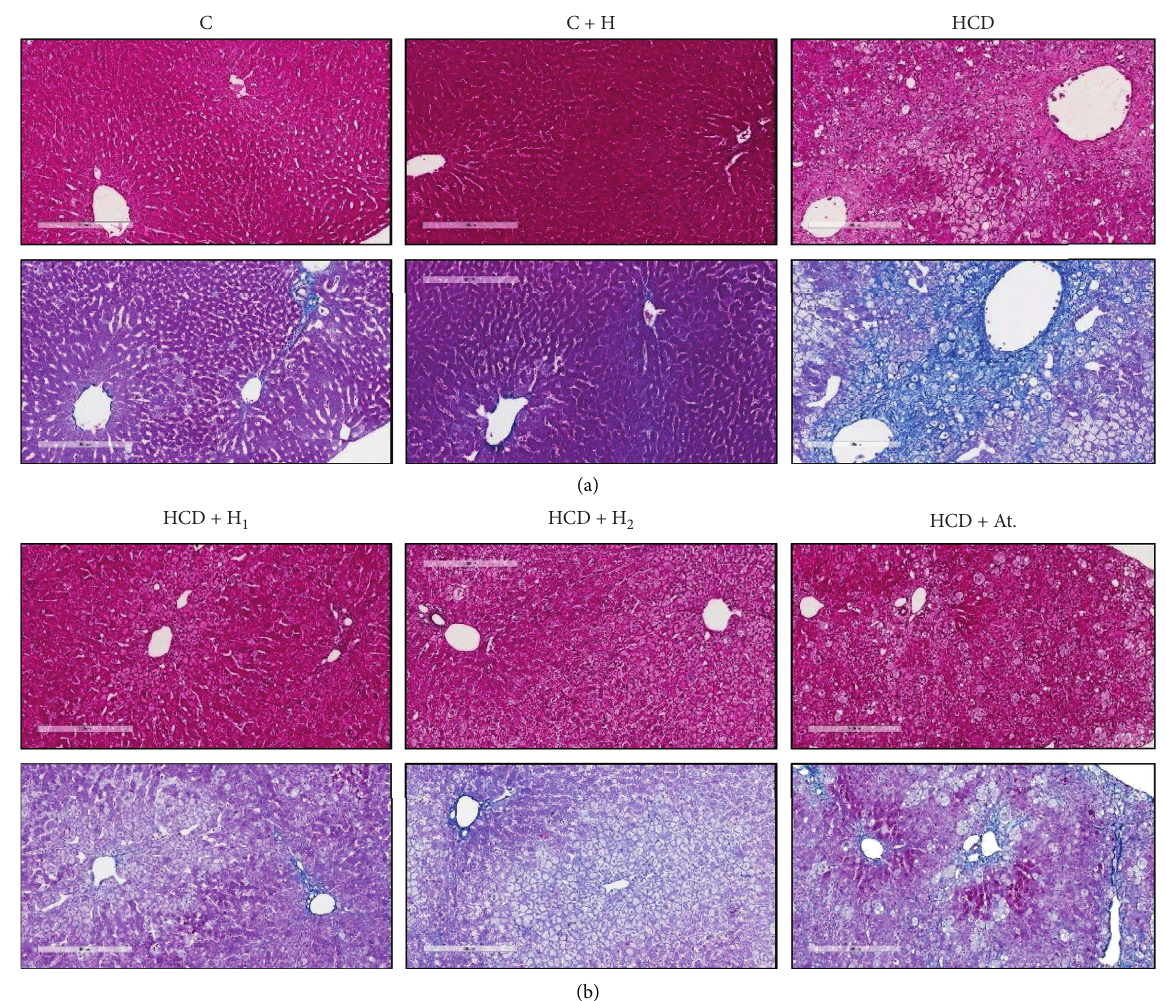
Figure 3: Microscopic features of a representative liver section from each experimental group: Haematoxylin and eosin stain (a); Masson’s trichrome stain